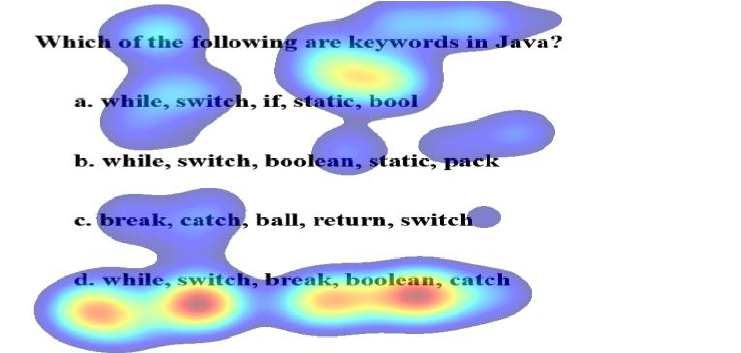
Figure 12. Heat map representing Lack of Confidence by an underperforming learner for MCQ3.